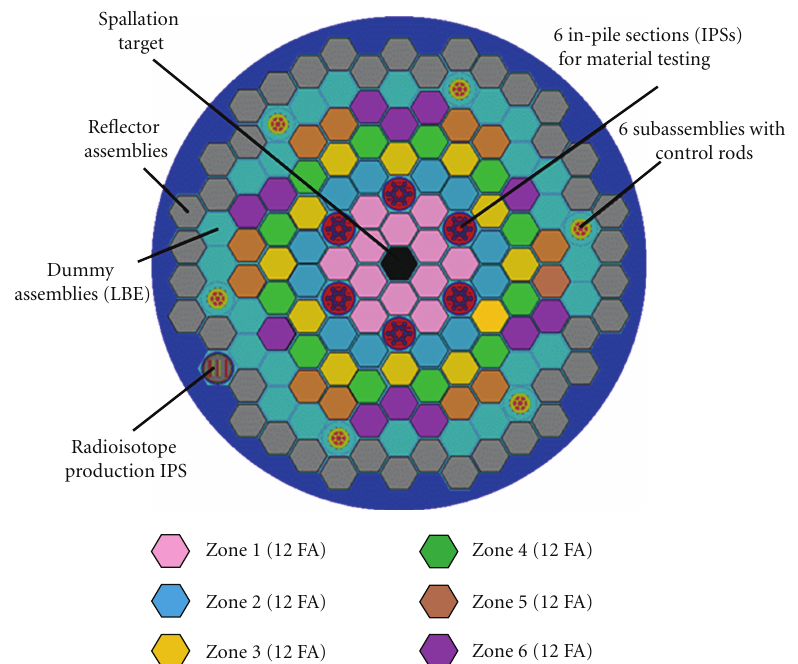
Figure 2: MYRRHA sub-critical core with 72 FA collected in 6 groups 12 FA each according to average neutron flux values.